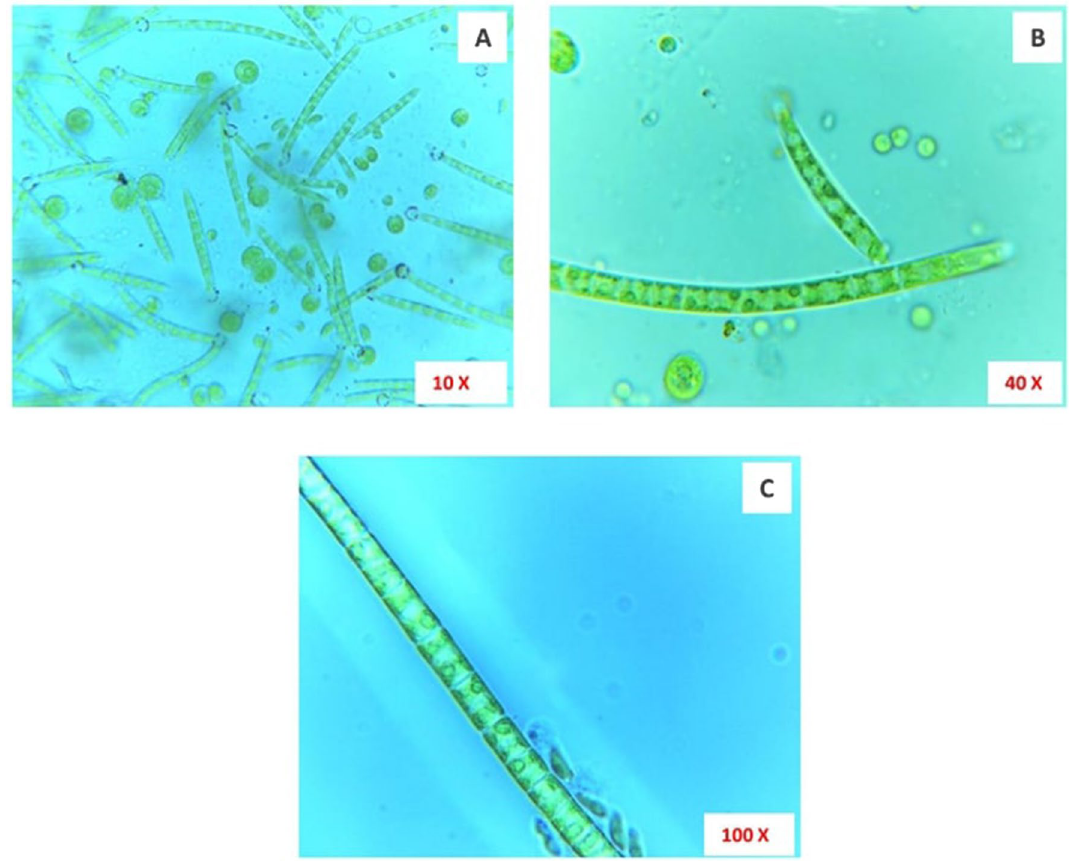
Figure 6. Microscopical images of isolated green algae colonized on the LDPE sheet. ( A ) × 10 magnification; ( B ) × 40 magnification and ( C ) × 100